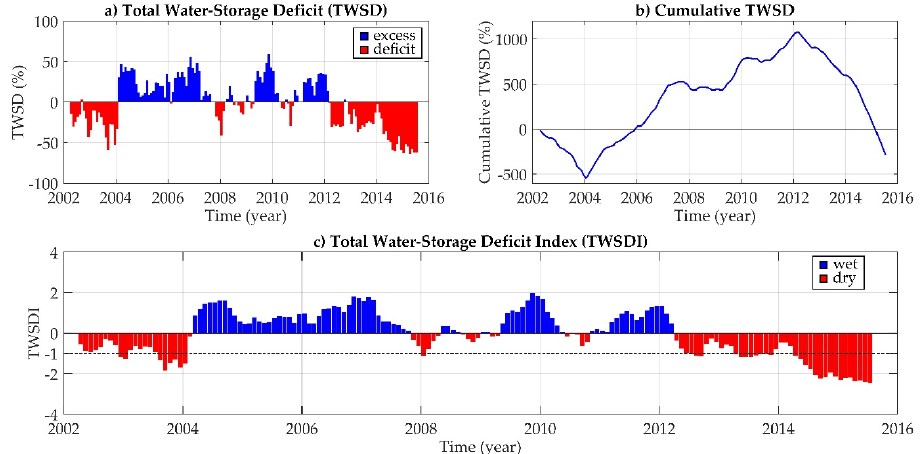
Figure 6. Panel ( a ) shows the TWSD for the SFRB over the period of April 2002 to July 2015 computed with Equation (4); panel ( b ) shows the cumulative TWSD for the SFRB; and panel ( c ) shows the TWSDI for the SFRB over the period of April 2002 to July 2015 computed with Equation (5).